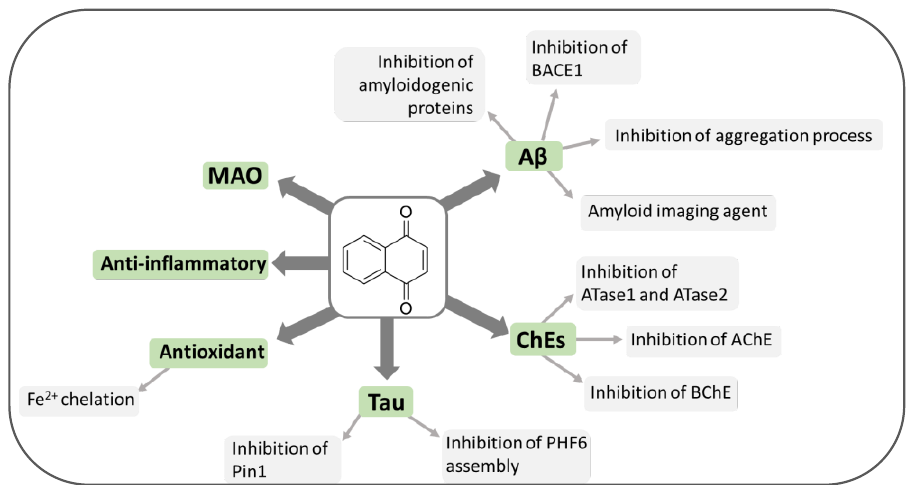
Figure 3. Biological profiles of 1,4-NQs in the treatment of Alzheimer’s disease.